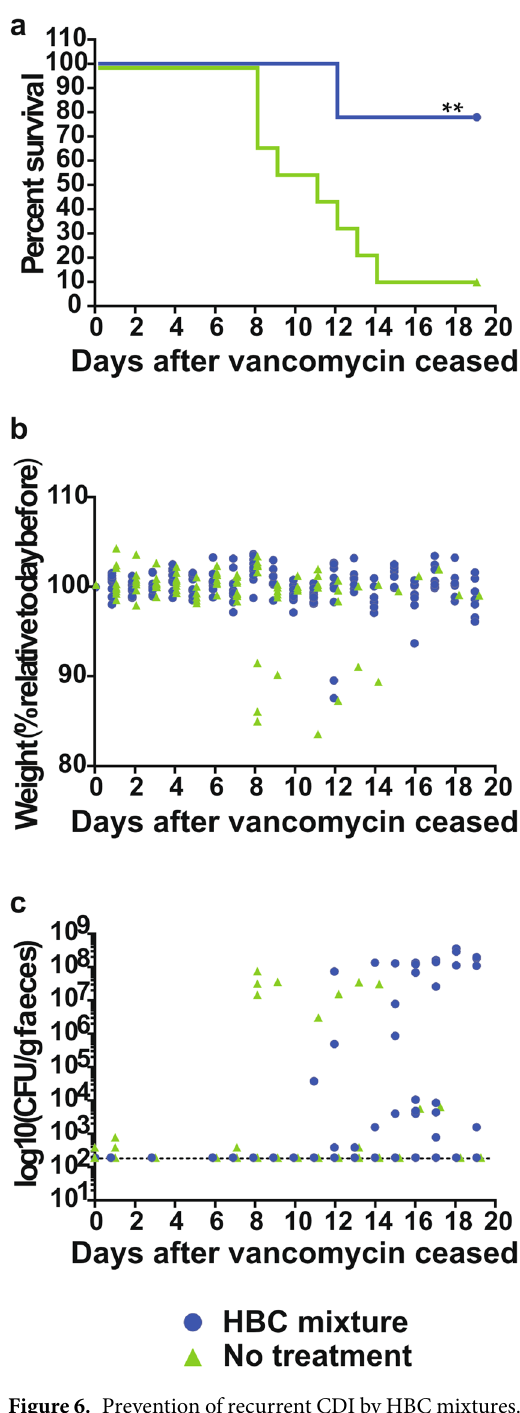
Figure 6. Prevention of recurrent CDI by HBC mixtures. Infected mice were orally treated with vancomycin prior to receiving either vancomycin or vancomycin and a mixture of Exo-HBC, SLP-HBC and TcdB-HBC. After vancomycin treatment ceased, mice either received no treatment or the HBC mixture. Mice were monitored daily for survival ( a ) and weight loss ( b ). Weight loss is presented as the % weight relative to the day before, with each point representing a single mouse. Faecal spore load was determined daily after cessation of vancomycin treatment and is presented as CFU/gram faeces (log 10 ) as described above ( c ). Error bars represent the mean ± SEM of n = 9 mice. ** Indicates P <